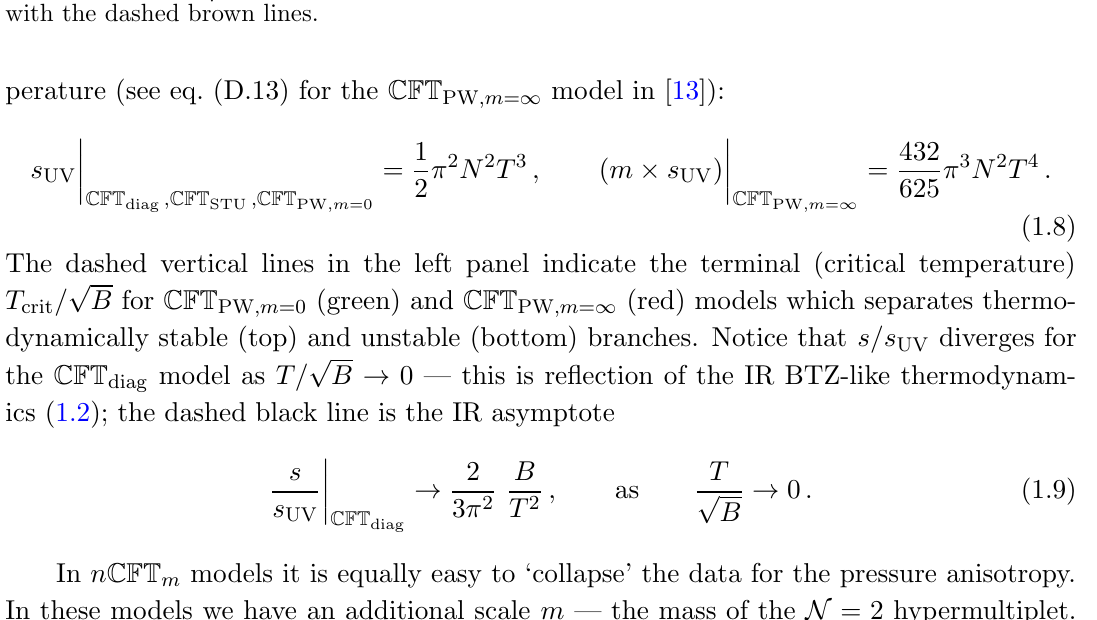
Figure 2 . Renormalization scale (cid:14) is adjusted separately for the CFT diag , CFT STU and CFT PW ;m =0 models (see (1.7)) to ensure that in all these models the pressure anisotropy R = 0 : 5 occurs for the same value of T p as in the CFT PW ;m = 1 model (see (1.6)). This matching point is highlighted B with the dashed brown